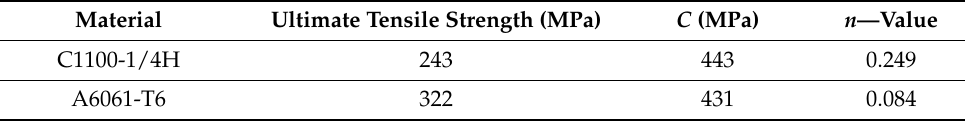
Table 1. Mechanical properties of test materials (Thickness 5